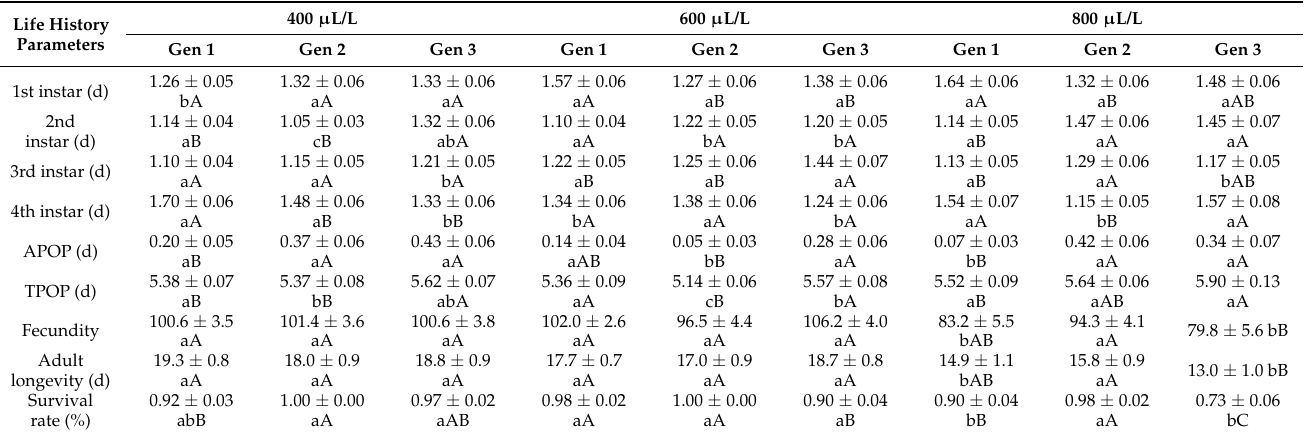
Table 1. Life history parameters of three successive generations of L. erysimi under three CO 2 treatments (mean ±